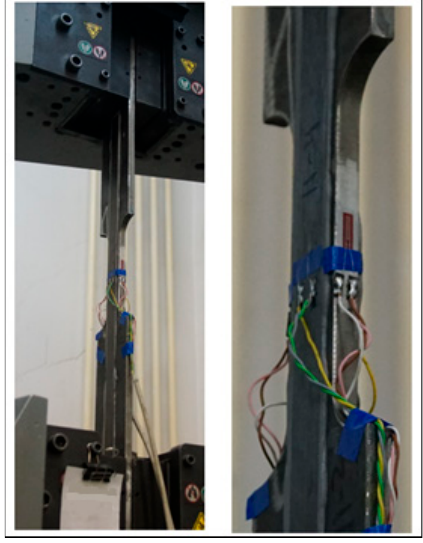
Figure 4. Strengthened